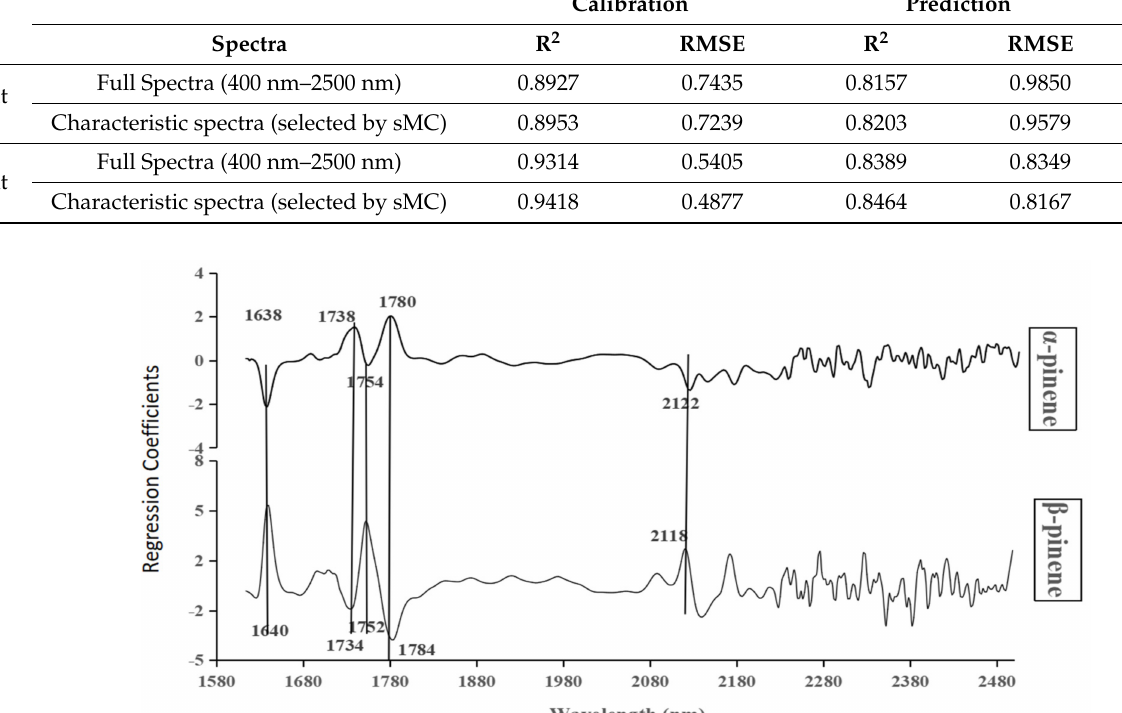
Figure 2. The range of characteristic spectra based on sMC for α -pinene and β -pinene and the regression coefficients of the spectra to the pinene content. The numbers near the curves are the wavelengths of the corresponding curve